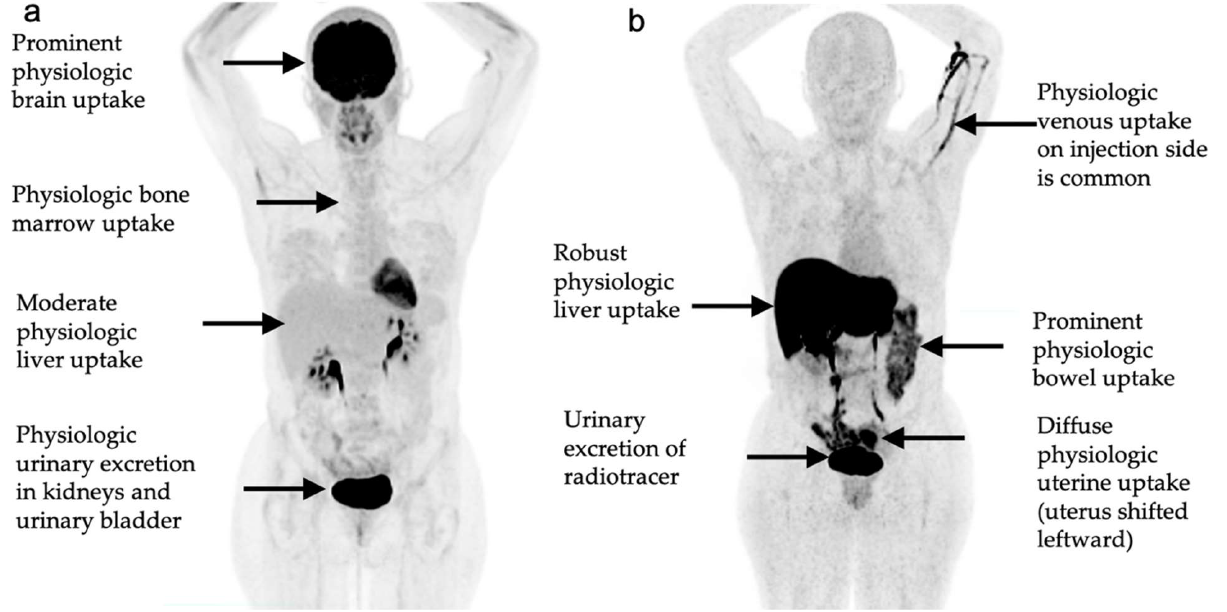
Figure 18. Normal physiologic biodistribution of PET radiotracer uptake for: ( a ) 18F- fluorodeoxyglucose (FDG); and ( b ) 18F-fluoroestradiol (FES). 18 F-NaF shows uptake that predominantly localizes diffusely throughout the bones and focally at sites of degenerative and/or post-traumatic change as well as sites of osseous metastatic disease (Figure 19). NaF PET-CT may occasionally show uptake in primary breast tumors irrespective of frank tumoral calcification, similar to that seen on 99m Tc bisphosphate bone scans, but demonstrates an overall low sensitivity for detection of non- osseous sites of breast cancer [105]. Note that incidental focal abnormal FDG uptake in a breast lesion seen on an FDG PET-CT exams performed for indications other than breast cancer has a likelihood of malignancy that ranges from 27 to 55% [103,106,107].